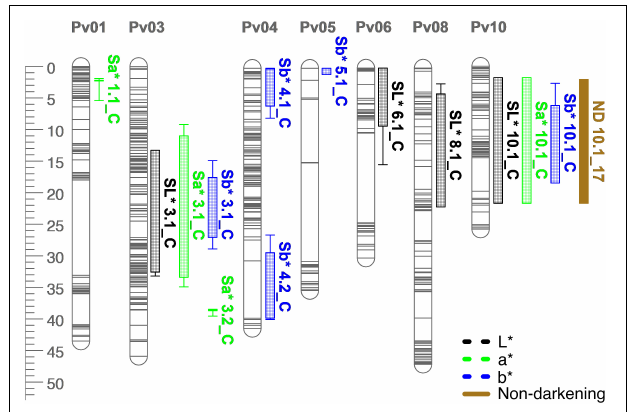
FIGURE 8 | QTL map for L*, a*, b*, and seed-coat postharvest non-darkening (ND) in the RIL population. Size is in cM. All QTL were detected in both years combined.